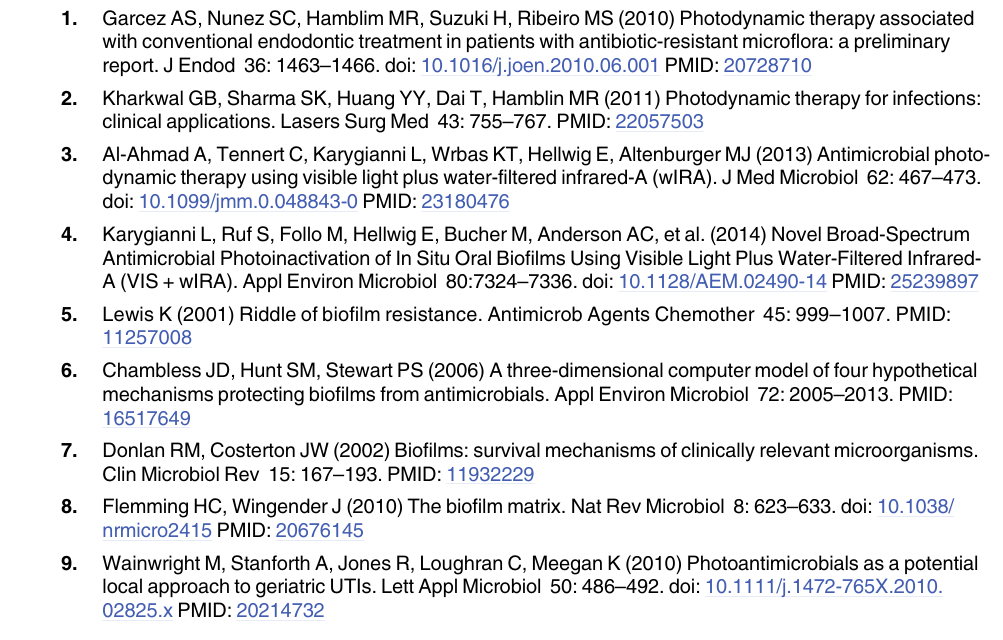
S2 Table. Raw data depicting the values of the colony forming units (CFUs) for each of the identified bacterial species after antimicrobial photodynamic treatment (aPDT). For aPDT, the photosensitizers toluidine blue (TB) and chlorine e6 (Ce6) were used to treat the initially adhered oral microorganisms. 0.2% Chlorhexidine (CHX) served as a positive control, while untreated initial biofilms were used as negative controls. The Log values as well as the bacterial diversity of the biofilms are also demonstrated on the tables. S3 Table. Raw data depicting the values of the colony forming units (CFUs) for each of the identified bacterial species after antimicrobial photodynamic treatment (aPDT). For aPDT, the photosensitizers toluidine blue (TB) and chlorine e6 (Ce6) were used to treat mature oral biofilms. 0.2% Chlorhexidine (CHX) served as a positive control, while untreated mature bio- films were used as negative controls. The Log values as well as the bacterial diversity of the bio- films are also demonstrated on the